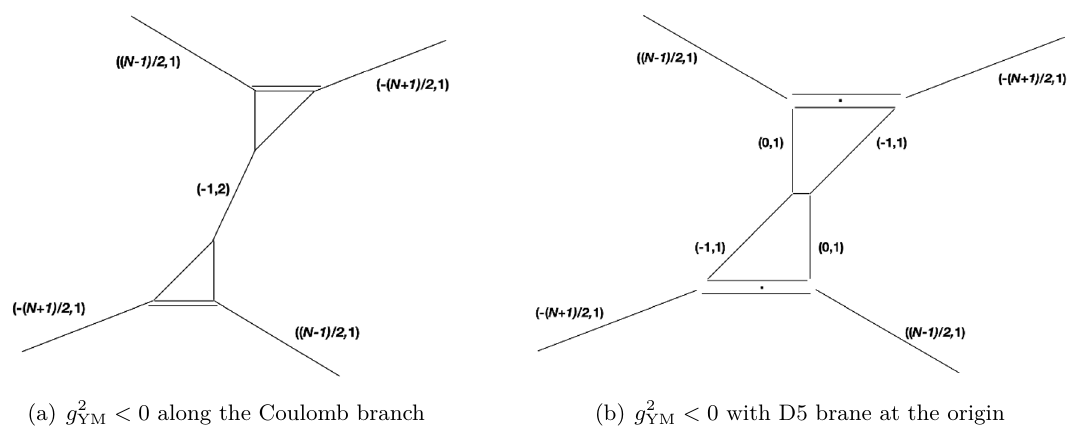
Figure 5 . ( p, q ) webs for N = 1 SU( N ) gauge theory with N odd at two points along the Coulomb branch from figure 4. (a) shows the hidden faces which merge to form a D5 brane in